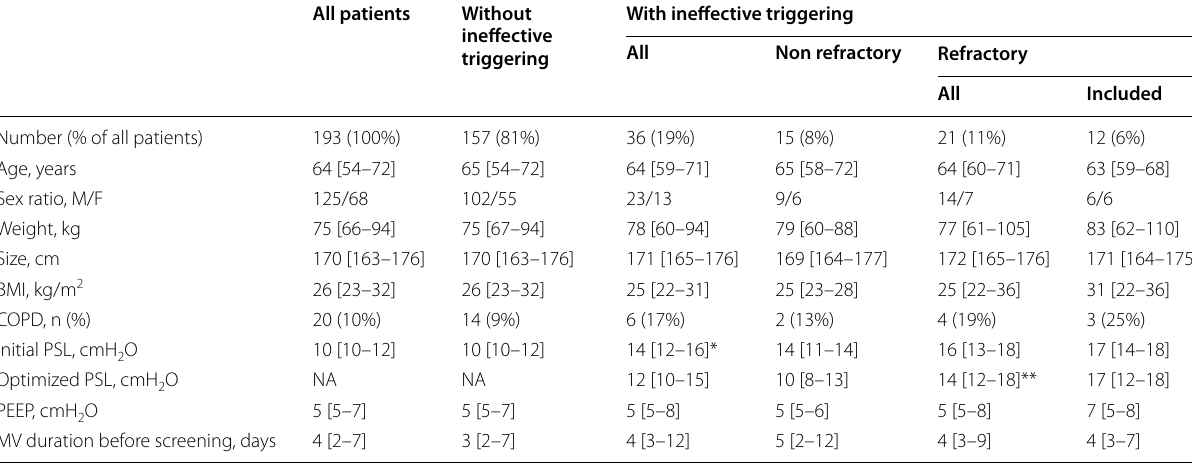
Table 1 Main characteristics of all screened